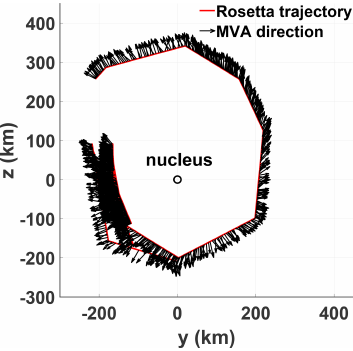
Figure 11. Illustration of the minimum variance angle projected onto the yz plane of the CSEQ frame for the time interval from 5 June to 15 August 2015. The solid red line at the base of the black arrows denotes the spacecraft trajectory, while the black ar- rows show the waves’ minimum variance direction. The vectors were adjusted so that all have the same orientation, which was arbi- trarily chosen to be pointing away from the